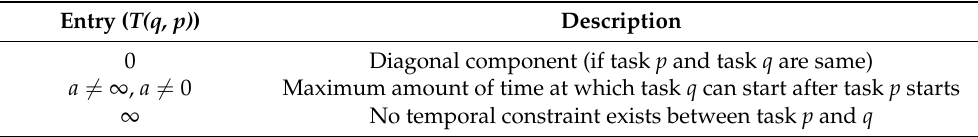
Table 4. Entry for temporal constraint matrix in